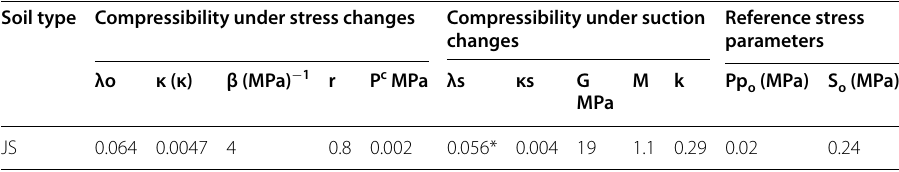
Table 4 BBM parameters selected as adapted from Cui and Delage